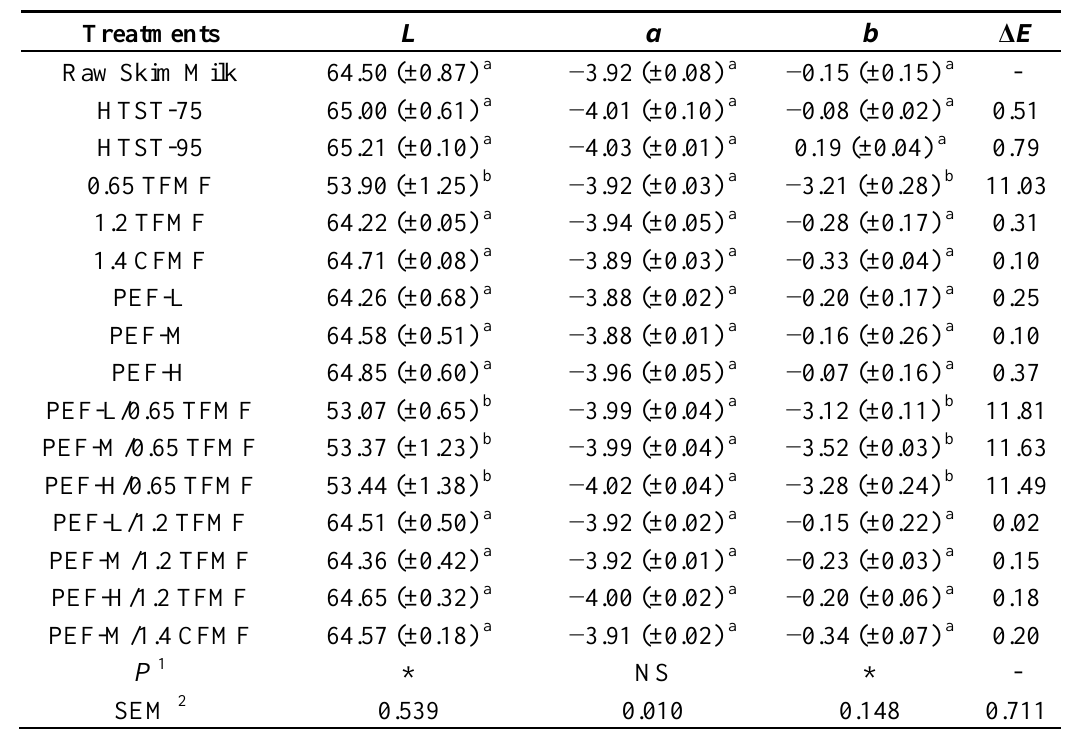
Table 1. Comparison of Hunter color space attributes L (lightness), a (redness) and b (yellowness) measured in raw skim milk and after processing with high-temperature short-time pasteurization at 75 (HTST-75) and 95 (HTST-95) °C, pulsed electric field at low (PEF-L), moderate (PEF-M) and high (PEF-H) intensities, 0.65 and 1.2 μm pore size tangential flow microfiltration (0.65 TFMF and 1.2 TFMF, respectively), 1.4 μm-pore size cross-flow microfiltration (1.4 CFMF), and different pulsed electric field-based combinations with the latter three membrane filtration